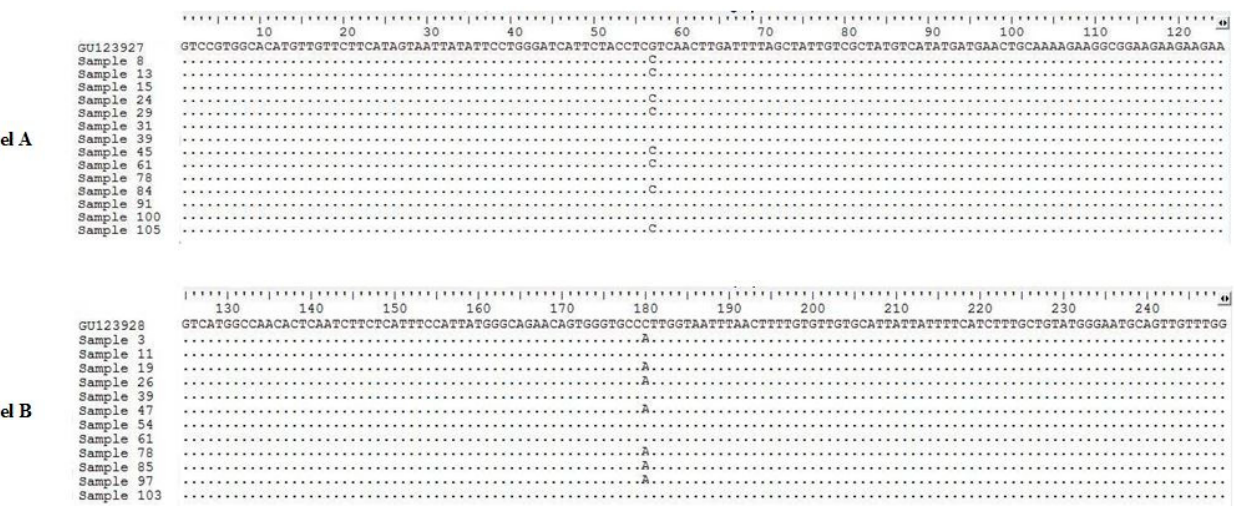
Figure 2. DNA sequence alignment of the voltage-gated sodium channel (VGSC) gene fragment encompassing nucleotides corresponding to the codons V419L (Panel A) and L925I (Panel B) in various C. lectularius specimens collected from Paris and suburb cities.